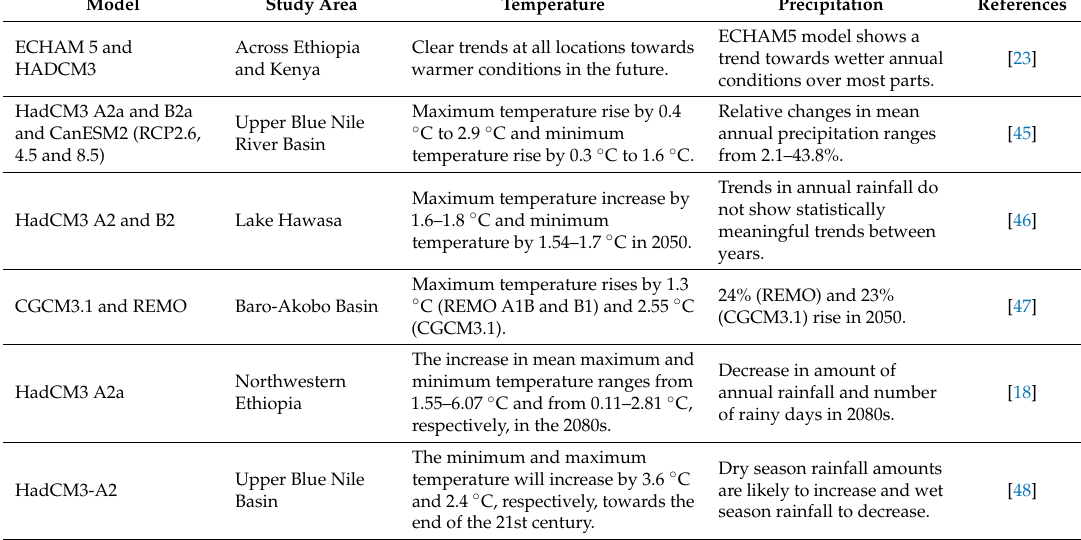
Table 5. Comparison of obtained changes with statistically downscaled research in different parts of